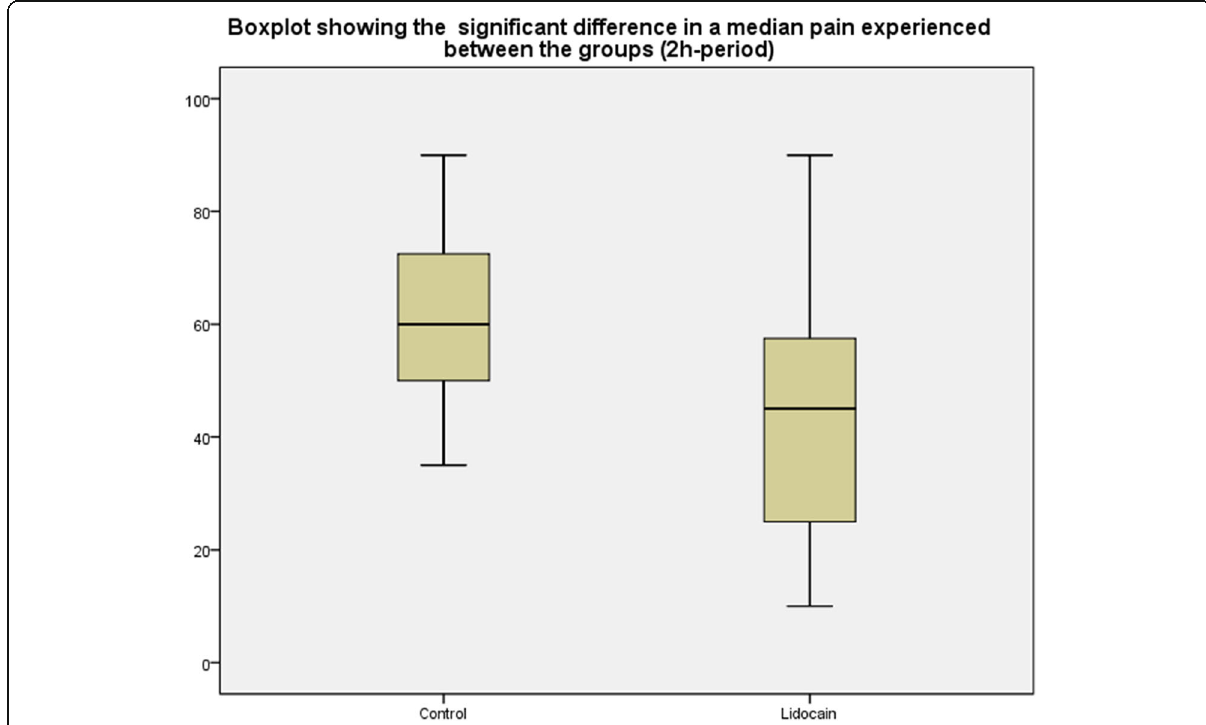
Fig. 1 Boxplot showing the significant difference in a median